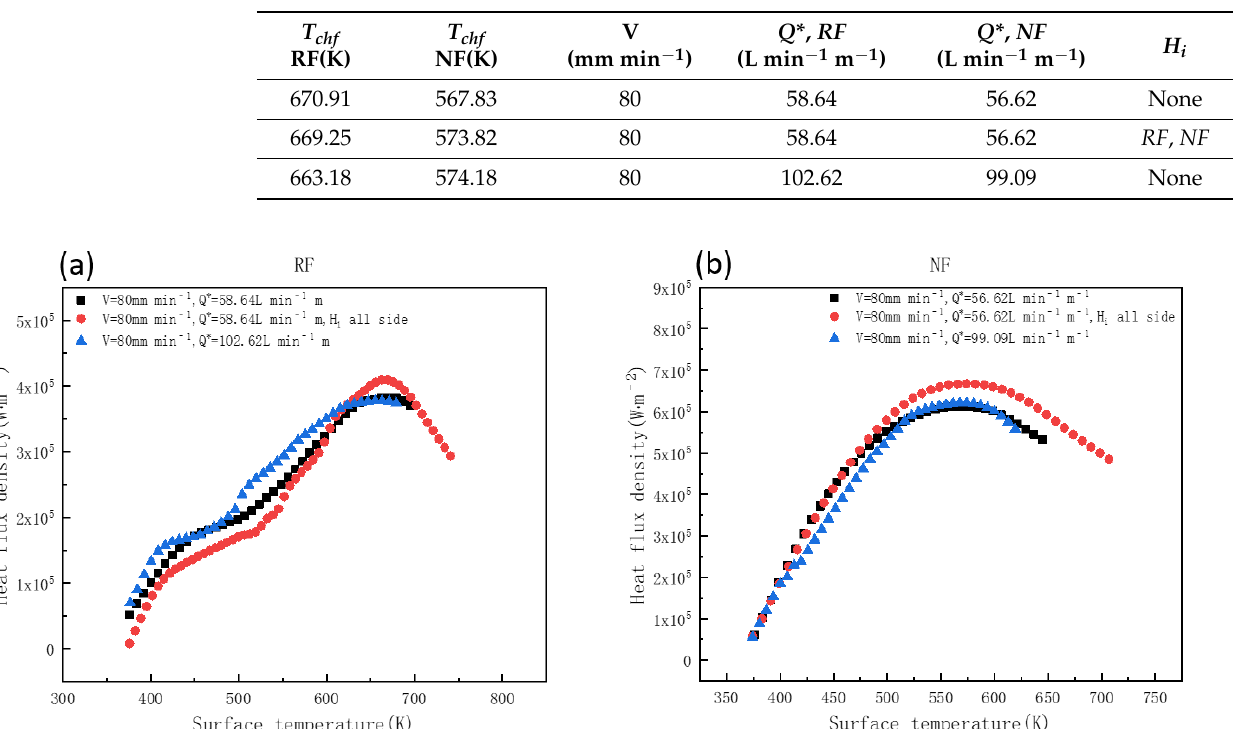
Figure 15. Boiling curves of DC casting at the secondary cooling zone with different casting parameters: ( a ) at RF ; ( b ) at NF .